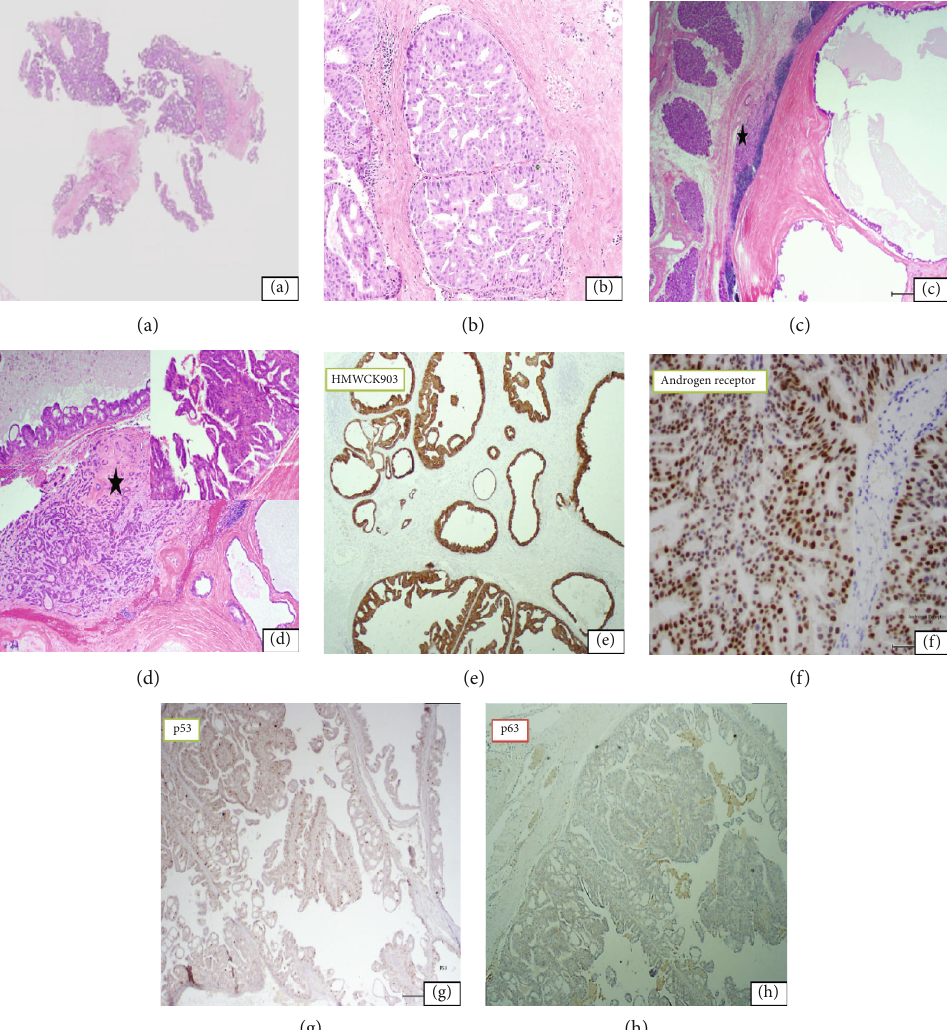
Figure 2: (a) Moderately di ff erentiated adenocarcinoma involving cores of fi brous connective tissue. H&E 2x. (b) High power view of the tumor revealed a cribriform pattern, moderate nuclear pleomorphism, and scattered mitoses. H&E 40x. (c) Neoplastic cystic structures in close proximity to lacrimal gland tissue (star) in a hyalinized stroma and lymphoid proliferation. H&E 2x. (d) Tumor that arose from a focus of pleomorphic adenoma (star) depicting cystic structures with small papillae. H&E 4x. Inset: papillary projections lined by large cuboidal cells with moderate nuclear atypia and apocrine features. H&E 20x. (e) Tumor cells were strongly positive for HMWK903 (4x). (f) Nuclear expression of androgen receptor was present in the tumor (20x). (g) p53, positive in less than 50% of tumor cells (4x). (h) p63 was negative within the invasive component of the tumor